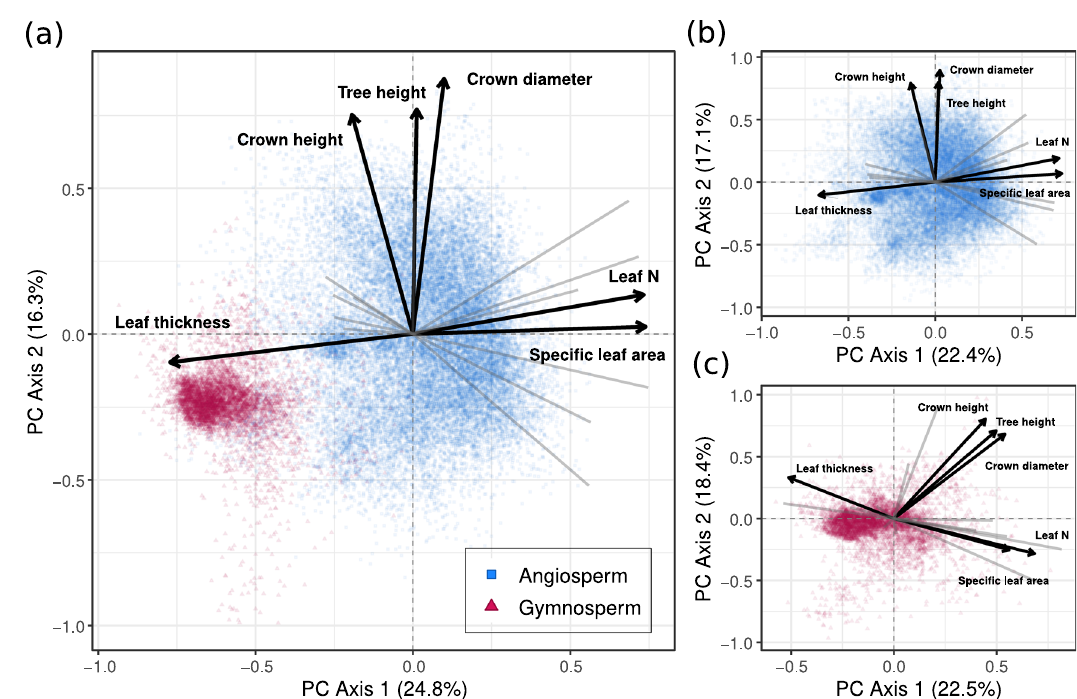
Fig. 2 The dominant trait axes and relationships. Shown are the fi rst two principal component axes capturing trait relationships across the 18 functional traits. a All tree species ( n = 30,146 observations), b angiosperms only ( n = 24,658), and c gymnosperms only ( n = 5498). In a the three variables that load most strongly on each axis are shown in dark black lines, with the remaining variables shown in light grey. These same six variables are highlighted in b and c illustrating how the same relationships extend to angiosperms and gymnosperms (see Supplementary Figs. 10 – 12 for the full PCAs with all traits visible, and Supplementary Table 5 for the PC loadings).